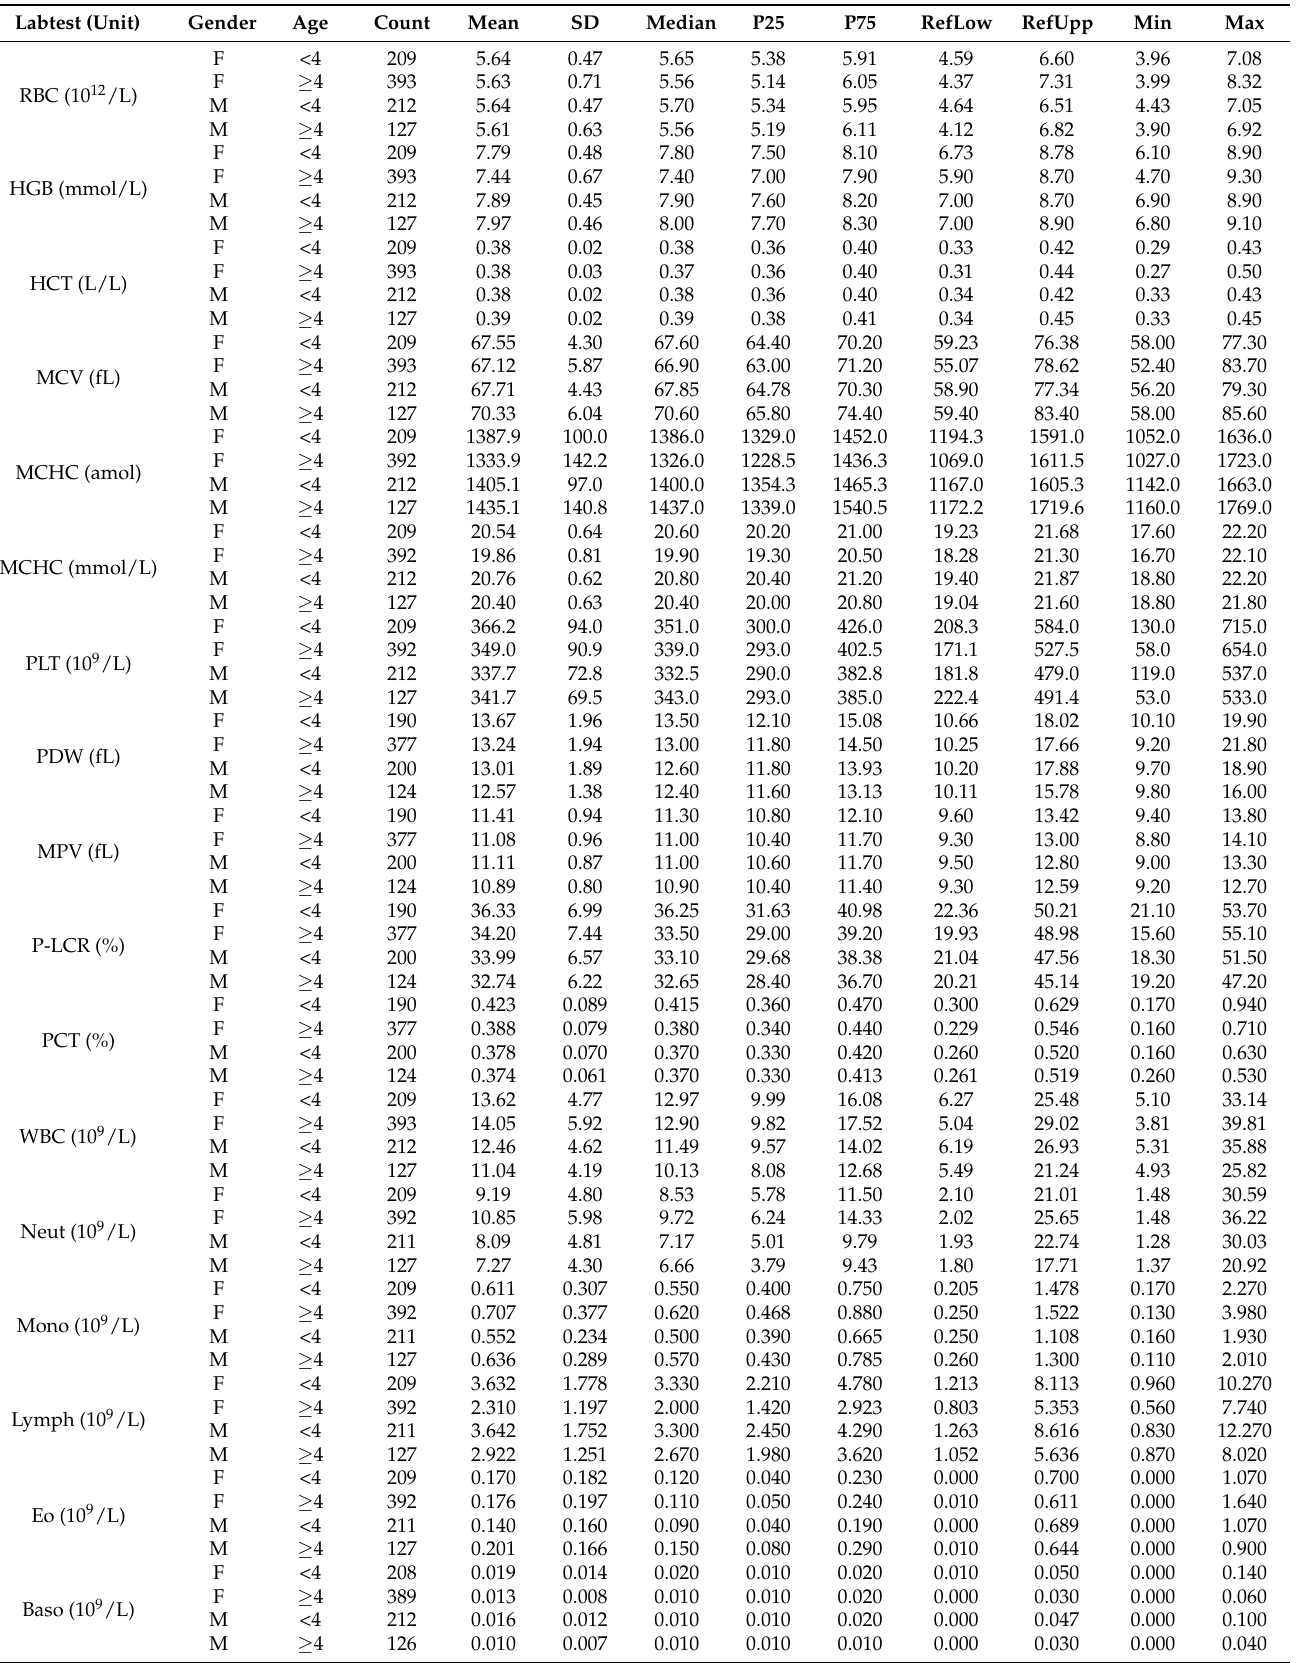
Table 6. Hematologic reference intervals and percentiles in the cynomolgus